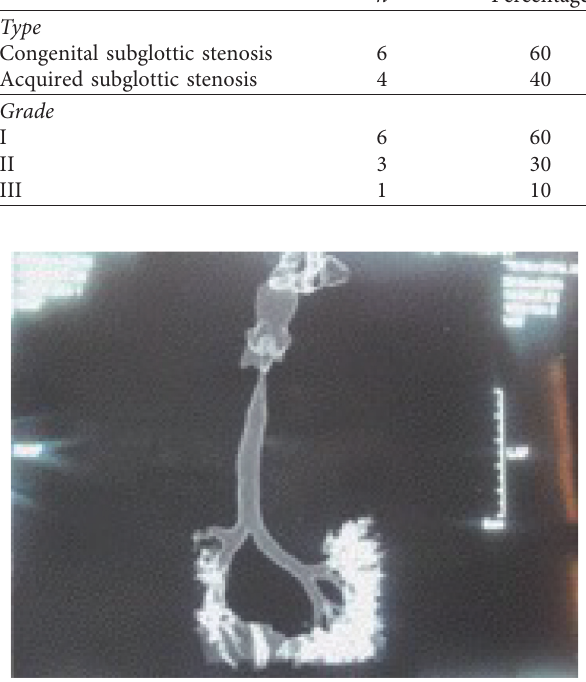
Figure 1: Subglottic stenosis with 3D reconstruction on a mul- tidetector CT in an 18-month-old child with aquired subglottic stenosis.